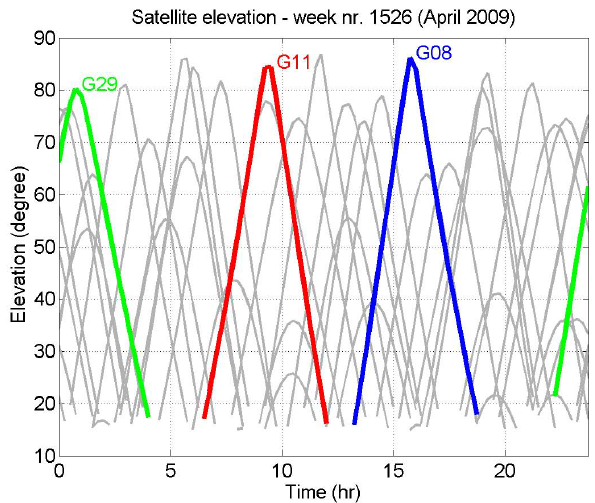
Fig. 6. Elevation of GPS satellites on week 1526 for the AQUI site (15 ◦ cut-off angle).